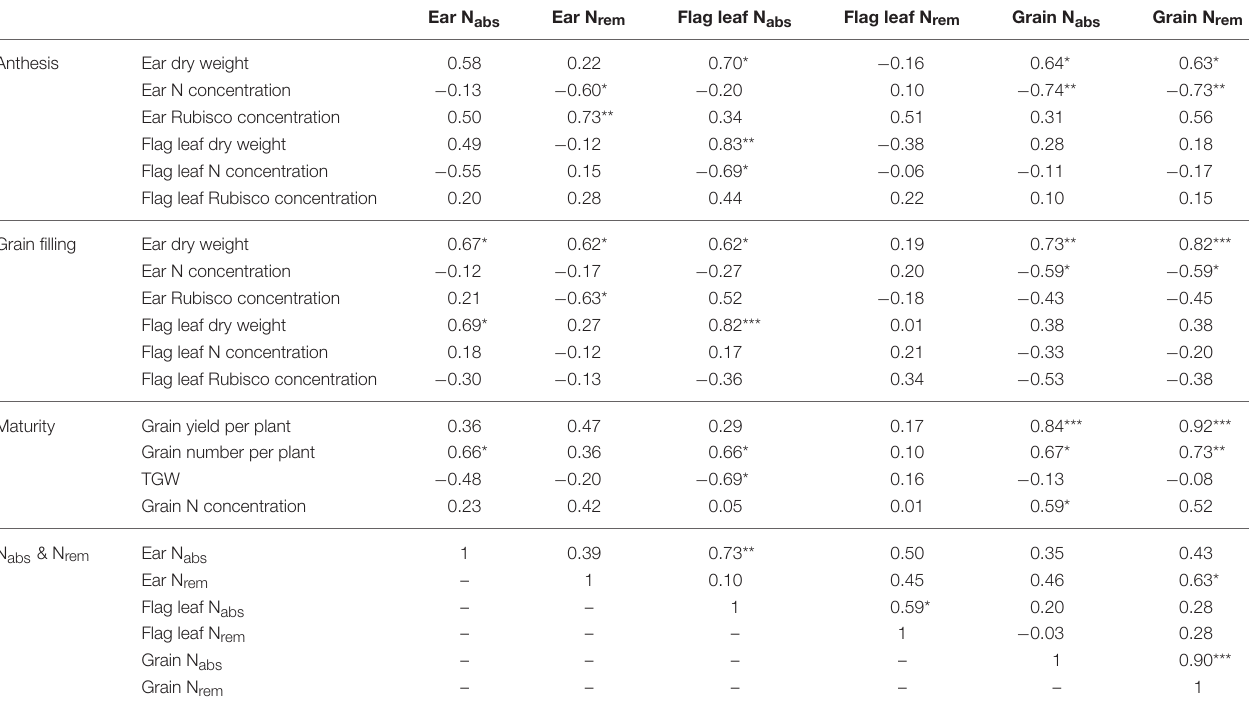
TABLE 4 | Pearson correlation coefficients between the N abs , and N rem of the ear, the flag leaf and the grain associated with dry weight, N concentration and Rubisco concentration in the dry matter of the ear (glumes) and the flag leaf blade at anthesis and grain filling, as well as the grain weight, grain number per plant, thousand grain weight (TGW) and grain N concentration at maturity.